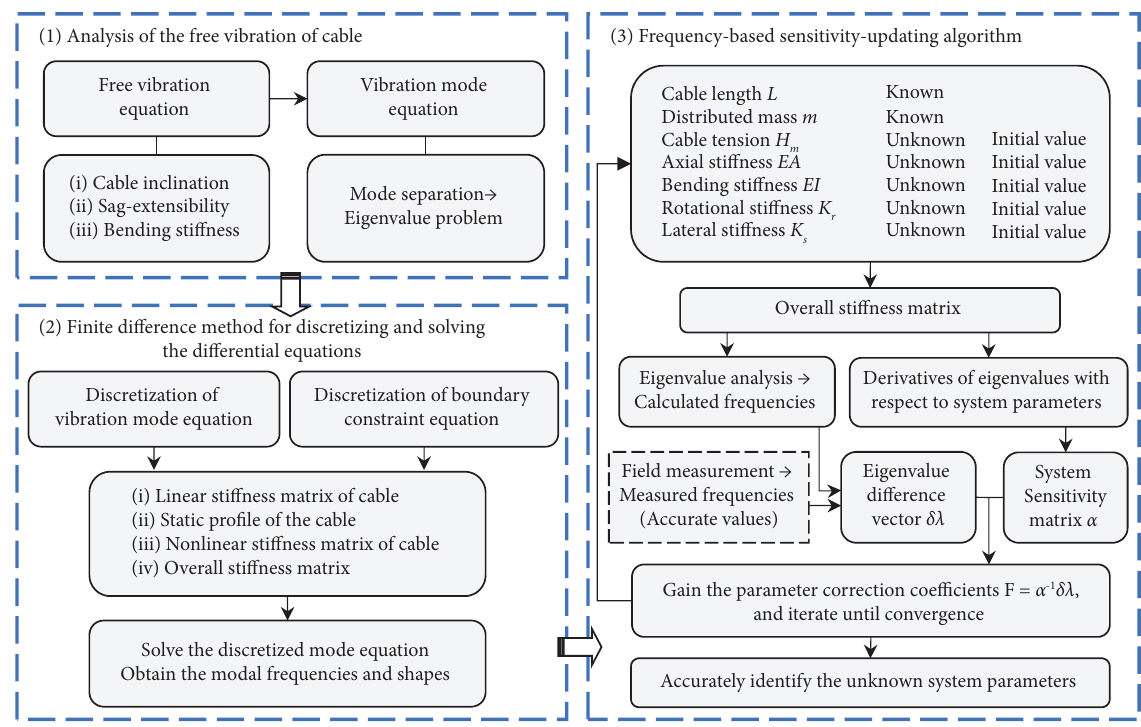
Figure 1: Overall idea